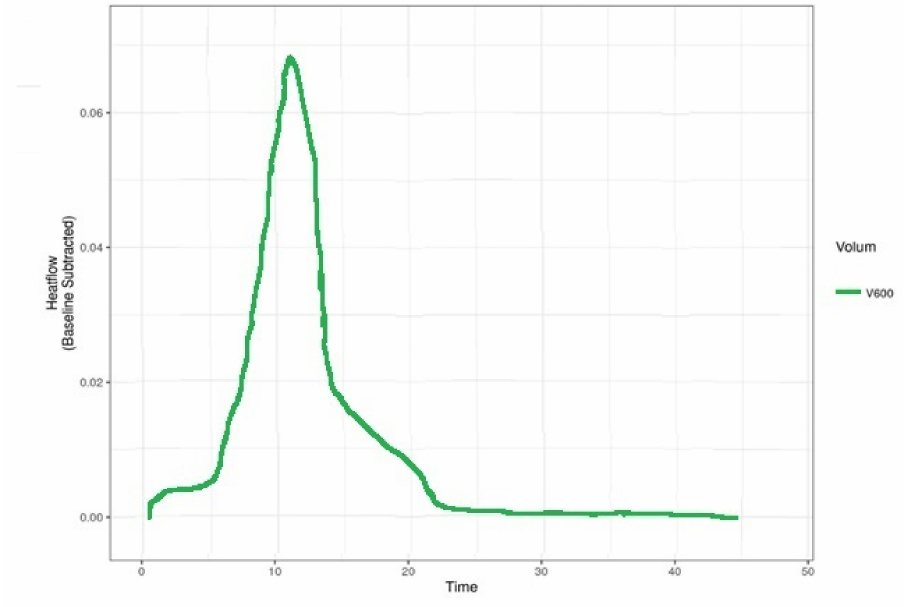
Figure 6. Graphical representation of the growth curve generated by the heat released by the active metabolism of S. Aureus—P3 . Experiments performed at 37 ◦ C and with a microcalorimetric cell load of 600 µ L.